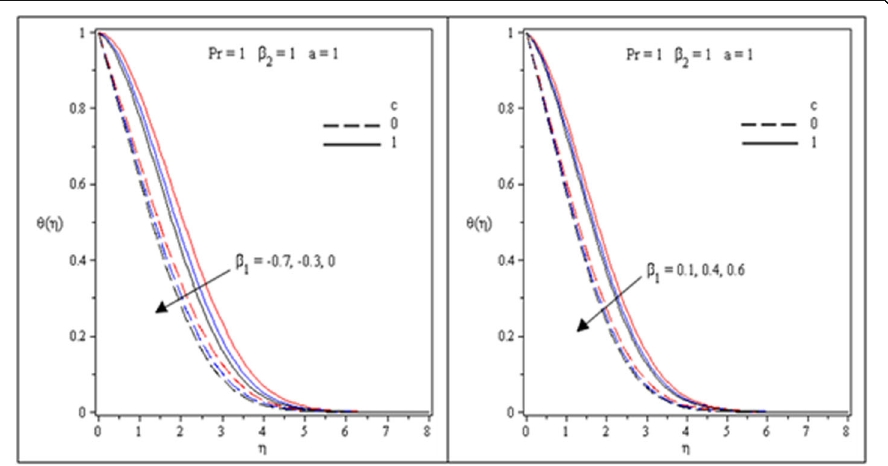
Fig. 3 Temperature profiles for the viscosity parameter with and without